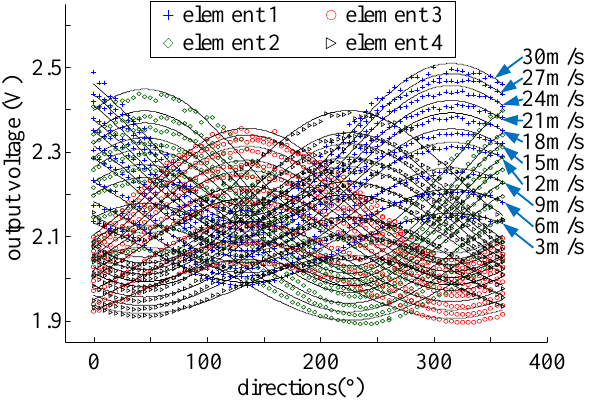
Figure 9. Output voltages of sensor versus the flow speed and flow direction (flow speeds are labeled for element 1 only).